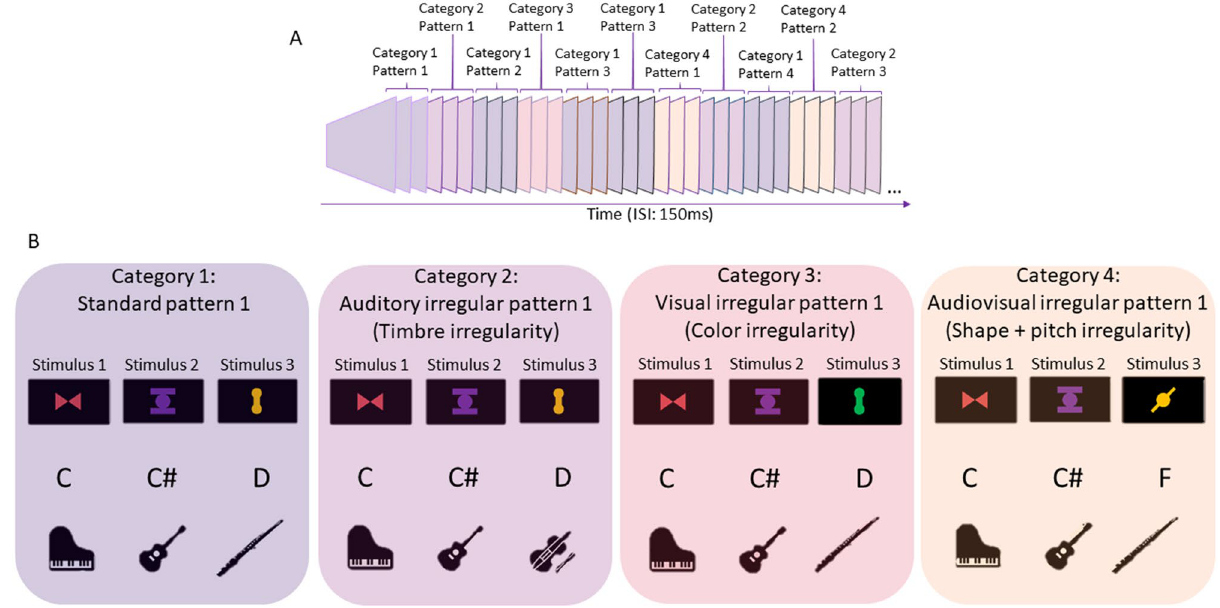
Figure 1. Example description of stimulation stream and stimuli categories: ( A ): Stimuli are presented in a continuous stream with constant ISI. Standard stimuli patterns and irregular ones of each category are randomly interleaved. ( B ): The first block presents one random stimulus pattern from the category of standard stimuli; all characteristics (shape, color, pitch, timbre) are paired according to the transitional probabilities of the multisensory stream. Second block represents the category of auditory irregular stimulus; timbre is altered by using the timbre of the first stimulus of another standard pattern, thus violating transitional probabilities of the auditory part of the stream. All other characteristics remain correct. Third block represents the category of visual irregular stimulus, color is altered by using the color of the first stimulus of another standard pattern, violating transitional probabilities of the visual part of the stream. All other characteristics remain correct. Fourth block represents the category of audiovisual incongruent stimulus; shape and pitch are altered, using the shape and pitch of the first stimulus of another standard pattern, thus violating transitional probabilities, while all other characteristics remain